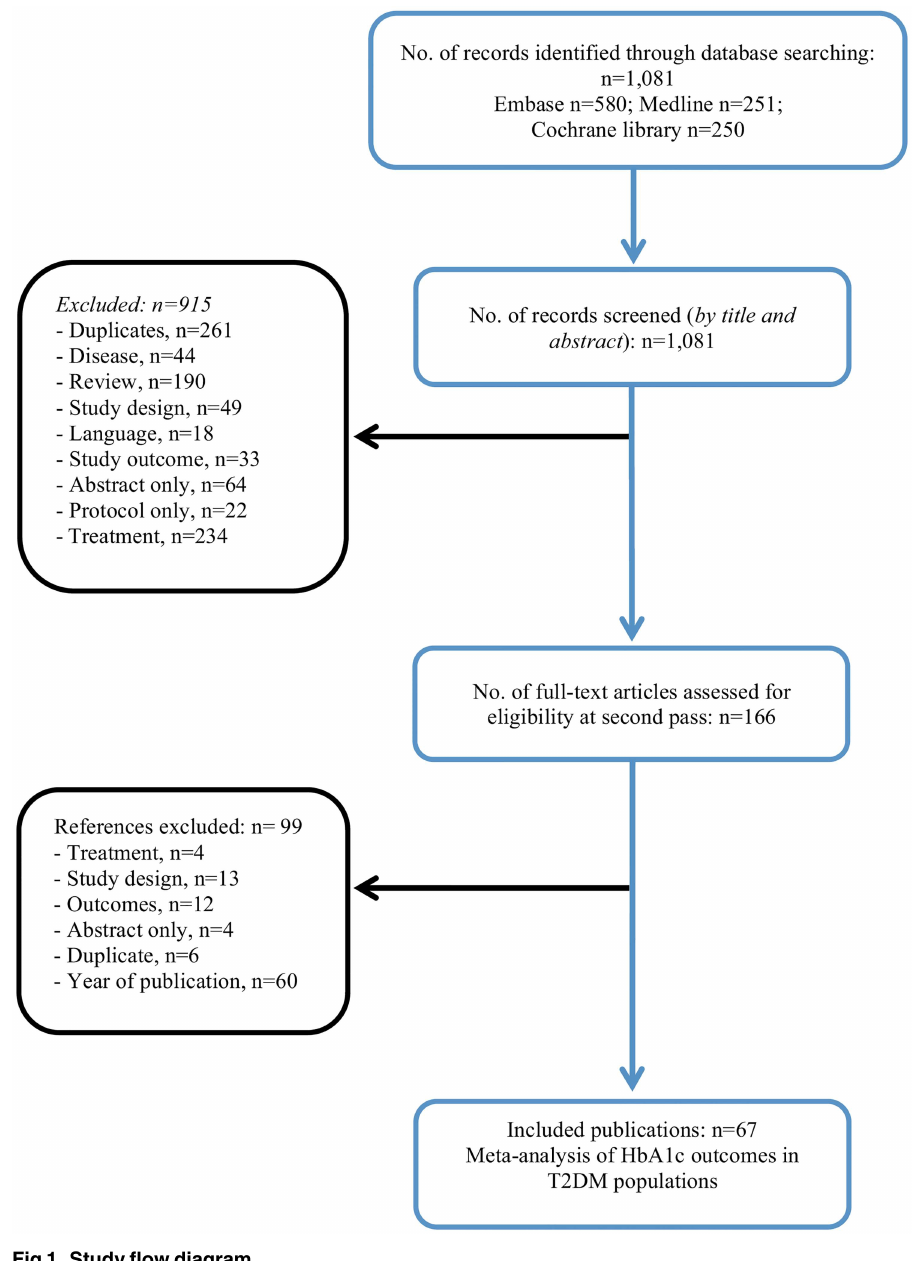
Fig 1. Study flow